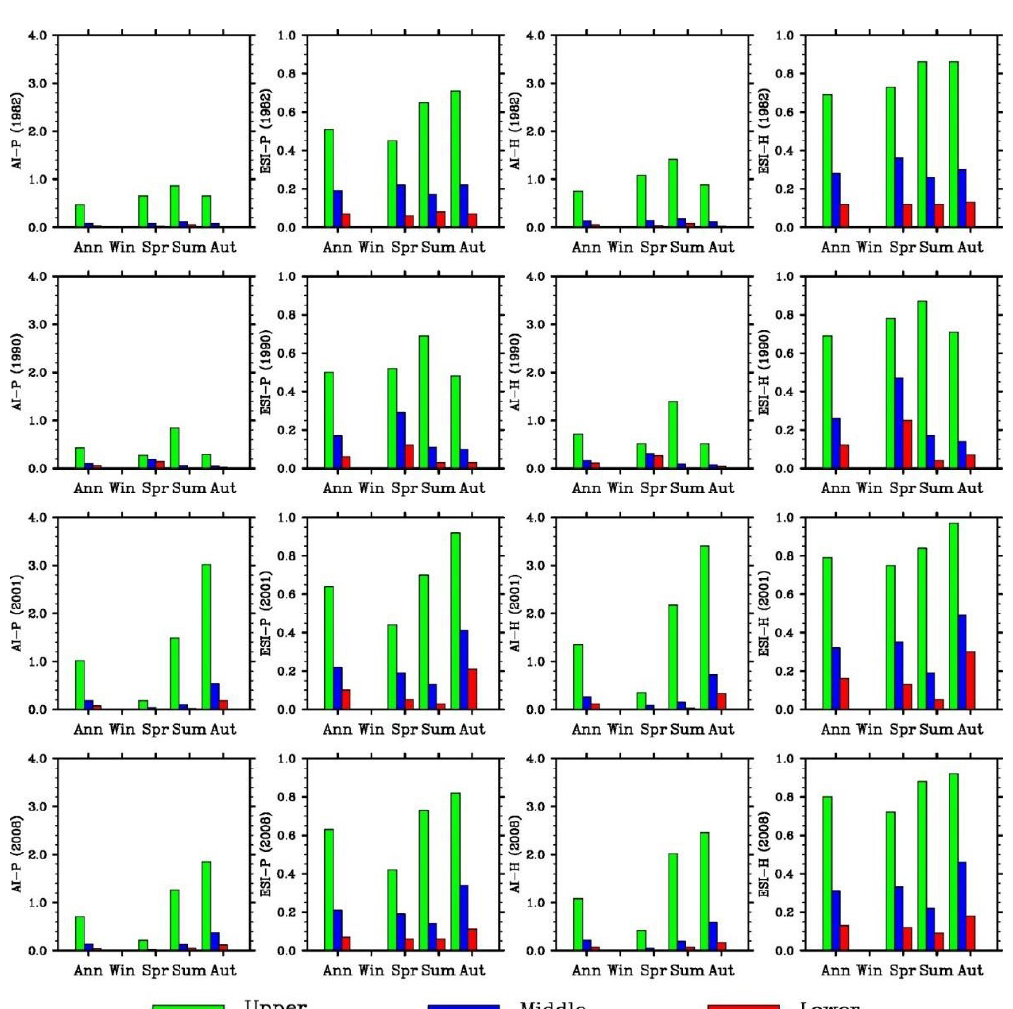
Figure 10. Seasonal variations of the simulated aridity index and evaporative stress index using the Penman–Monteith and Hamon methods (left to right) for the dry years of 1982, 1990, 2001, and 2008 (from top to bottom).